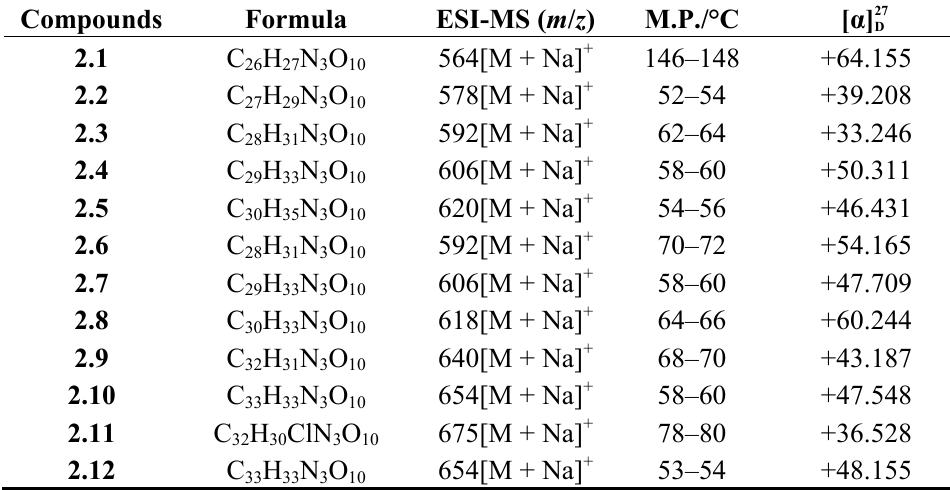
Table 1. Experiment data of compounds 2.1 – 2.12